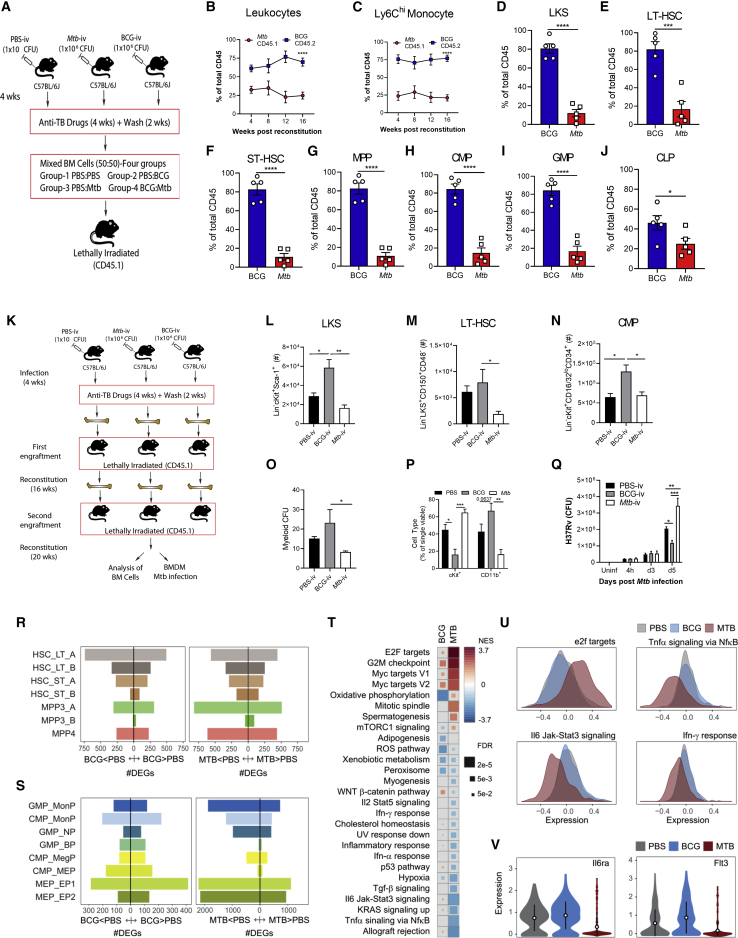
Mtb-i.v. Causes BM Exhaustion and Has Long-Term Effects on BMDM Training(A) Mixed chimera model.(B and C) Percentage of CD45.1+ versus CD45.2+ leukocytes (B) or Ly6Chi monocytes (C) in the blood (n = 5–10/group).(D–J) In the BM, percentage of LKS cells (D), LT-HSCs (E), ST-HSCs (F), MPPs (G), CMPs (H), GMPs (I), and CLPs (J) after 16 weeks of reconstitution.(K) Secondary engraftment model.(L–N) Number of LKS cells (L), LT-HSCs (M), and CMPs (N).(O and P) Myeloid colonies (O) and cell type by flow cytometry (P) by BM methylcellulose CFU assay.(Q) In vitro BMDM CFUs.(R and S) Number of genes up- and downregulated by Mtb and BCG in each cluster (abs(logFC) > 0.1 and FDR < 0.05) of LKS cells (R) and cKit+ cells (S).(T) GSEA of genes ranked according to BCG (left) or Mtb (right) effects in the GMP_MonP cluster.(U) Distribution of expression levels in GMP_MonP for gene set average markers in four different hallmark gene sets.(V) Il6ra and Flt3 expression in the GMP_MonP cluster.Two-way ANOVA followed by Sidak’s multiple comparisons test was used in (B), (C), (P), and (Q). One-way ANOVA followed by Tukey’s multiple comparisons test was used in (L)–(O). In (D–J), two-tailed Student’s t test was used to assess differences. In (B) and (C), only significant differences at 16 weeks are depicted. See also Figure S7.